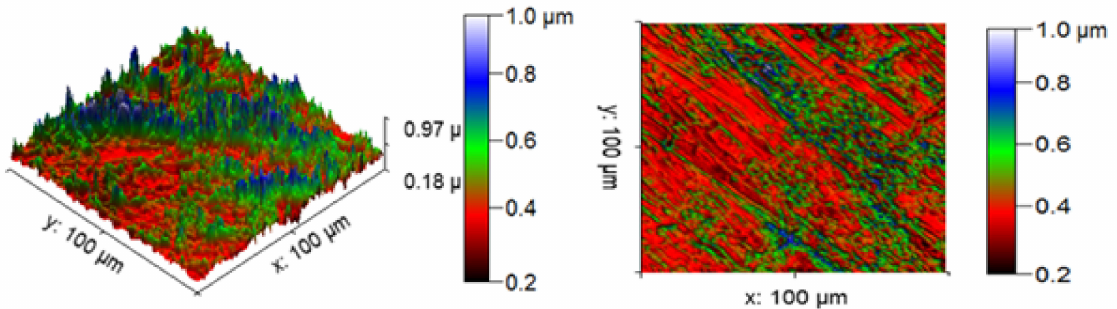
Figure 30. Corrosion test specimen (aximum corrosion).